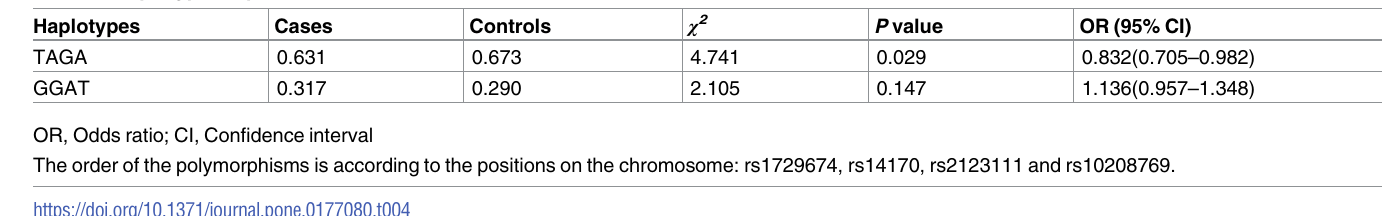
Table 4. Haplotype frequencies in AS and